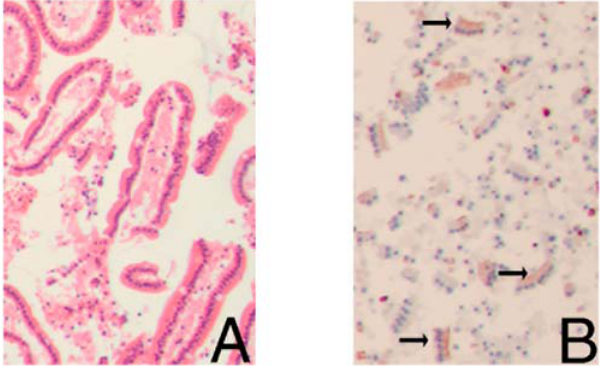
Figure 6. Histological analysis of H&E stained AgarCyto-fixed debris, appearing from the lumen of the jejunum after 30 minutes ischemia and more than 60 minutes ischemia, shows sheets of enterocytes (100 6 ). (A), containing many M30 positive cells (arrows) in red (AEC) (100 6 ) (B).